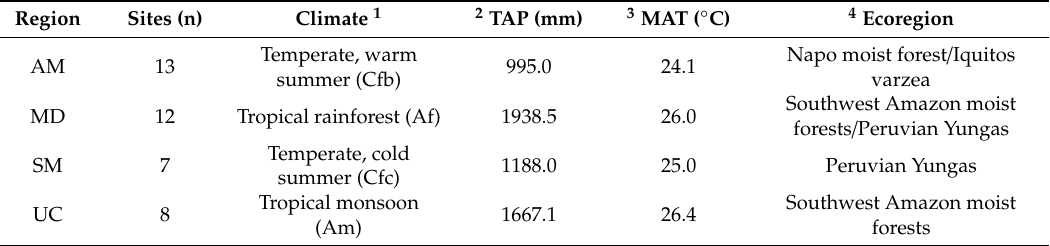
Figure 2. Sampling sites in the four regions: ( A ) Madre de Dios, ( B ) Ucayali, ( C ) San Martin, and ( D ) Amazonas. Table 1. Description of the study regions: Madre de Dios (MD), Ucayali (UC), San Martin (SM), and Amazonas (AM).